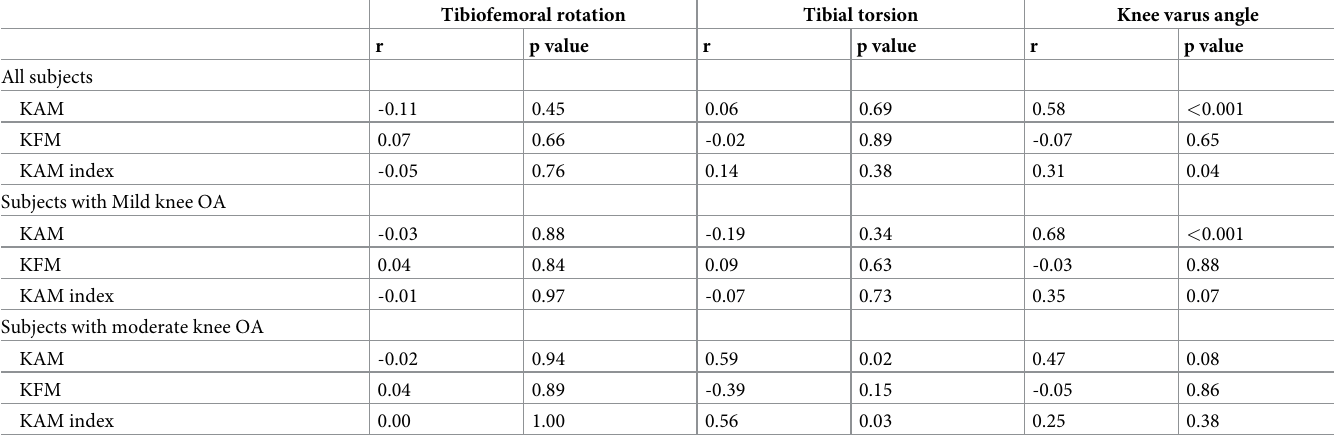
Table 2. Correlation between alignments and knee joint loads in medial knee